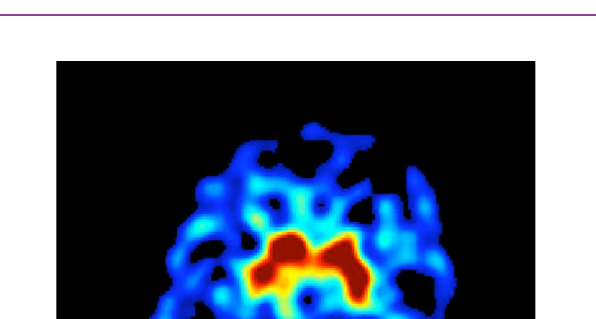
Figure 1. Time-activity curves.